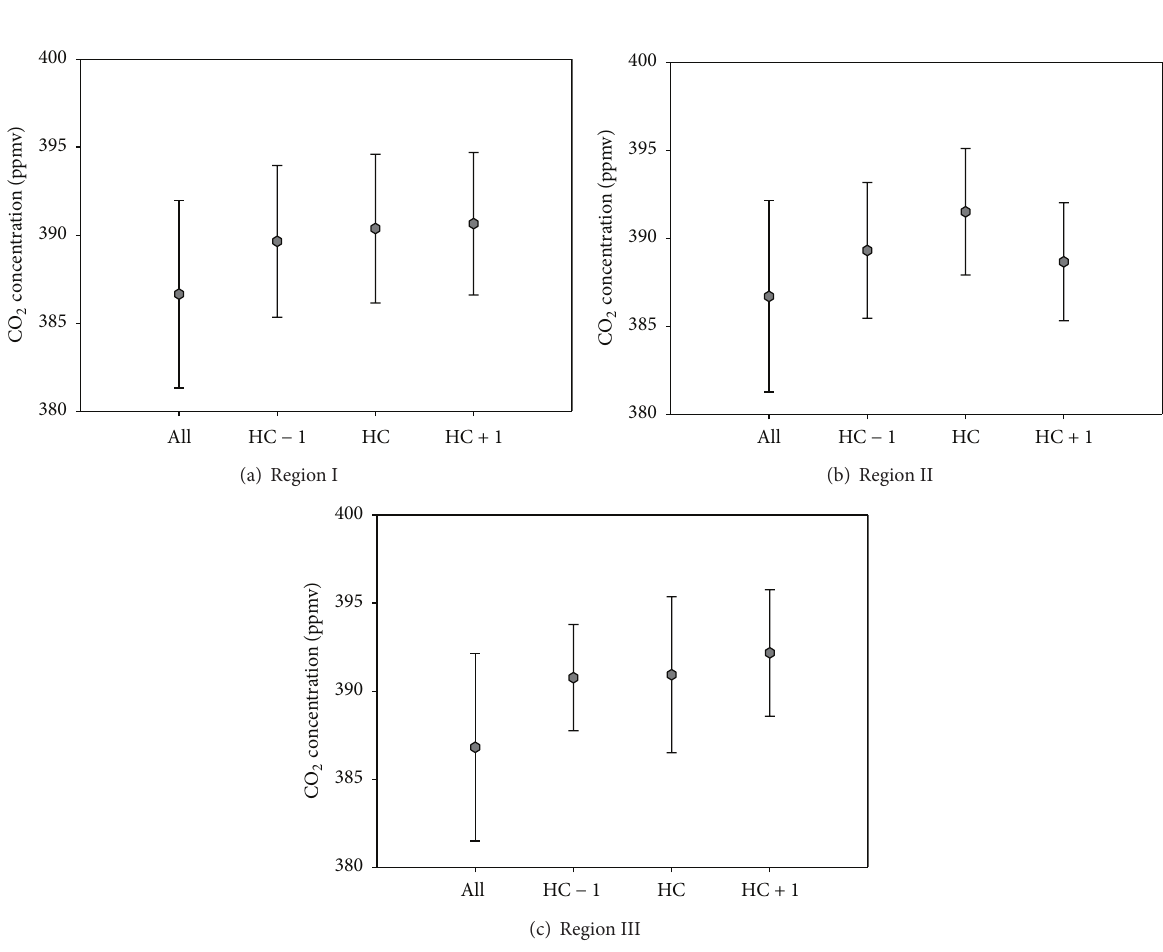
Figure 7: Regional mean of the column-averaged CO 2 concentration and its standard deviation on HC − 1, HC, and HC + 1 and for all periods (All) using GOSAT SWIR. (a) Region I (30–60 ∘ N, 110–120 ∘ E), (b) Region II (30–60 ∘ N, 120–130 ∘ E), and (c) Region III (30–60 ∘ N, 130–140 ∘